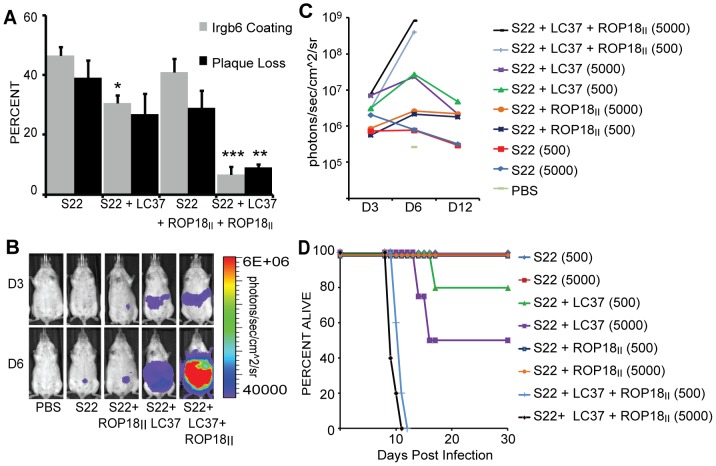
Virulent ROP5 promotes IRG evasion, independently of ROP18.(A) Quantification of Irgb6 localization on the parasitophorous vacuole (PV) and percentage plaque loss on IFNγ-stimulated MEFs compared to unstimulated MEFs infected with S22, S22 + ROP18II, S22 + LC37 and S22+ LC37 + ROP18II. Mean + SEM, n>4 experiments, *p<0.05, **p<0.01, ***p<0.001, One-way ANOVA with Bonferroni correction for all pairwise comparisons. (B) In vivo imaging of mice infected with firefly luciferase-expressing parasites of the indicated strains at days 3 and 6 post infection with 5000 parasites. One representative of 5 infected mice per strain is shown. (C) Quantification of in vivo imaging shown as average photons/sec/cm2/sr for infected mice at days 3, 6 and 12. (D) Mouse survival of infection with indicated doses of each strain.